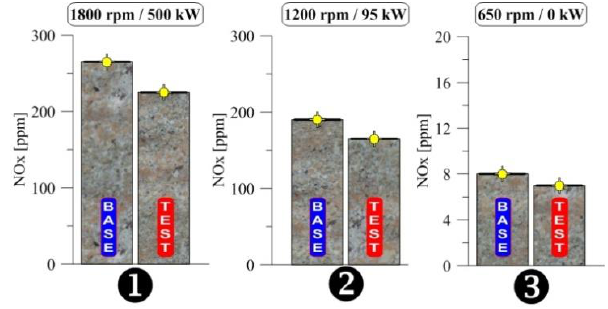
Fig. 18. The concentration of nitrogen oxides (NO x ) of the CAT C27 engine powered by the base fuel (BASE) and the base fuel with nitrON ® (TEST), for 3 points of test F (  )